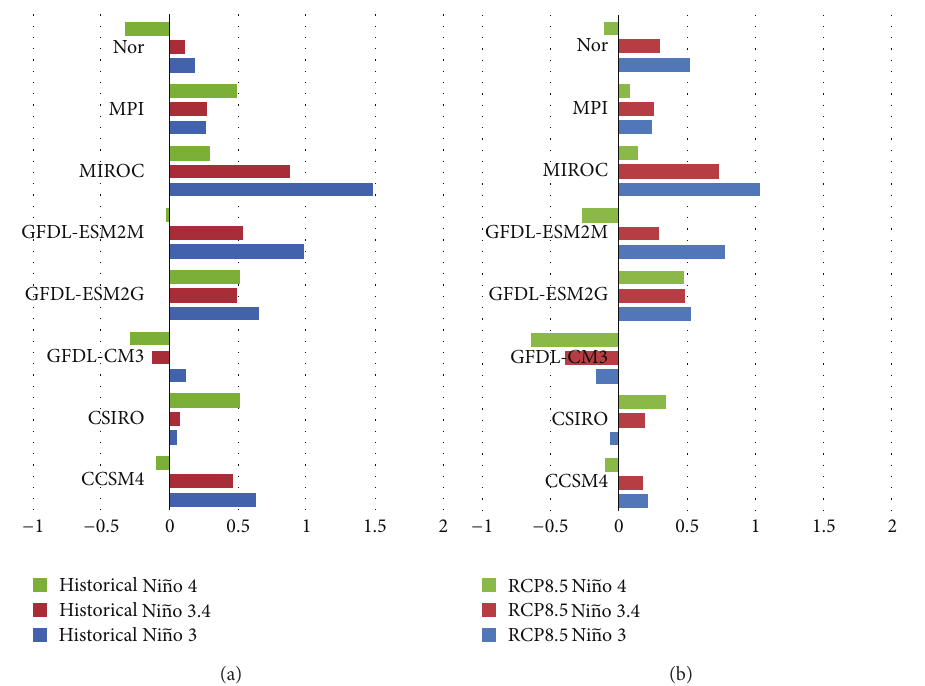
Figure 11: Ensemble member averaged skewness of November ENSO indices for historical (a) and RCP8.5 (b) experiments, respectively.